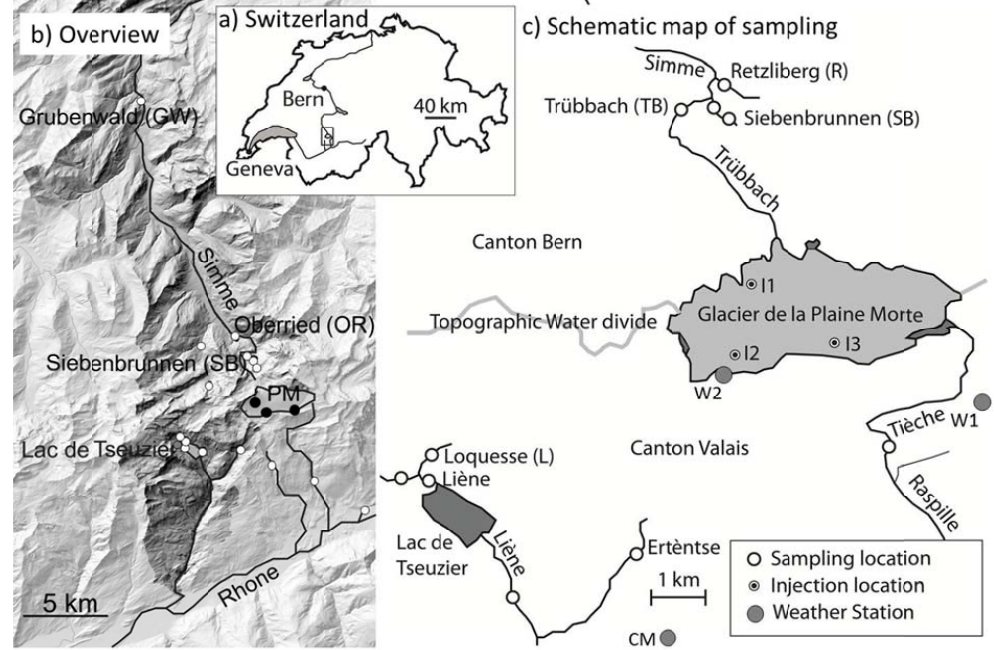
Fig. 1. Overview of the study site including the surroundings of the Glacier de la Plaine Morte (PM). (a) locates the study area with a square in Switzerland, (b) gives a topographic overview of the two valleys to the north and south of the PM (darkened area delimits topographic watershed of the Simme and the Liène); (c) illustrates schematically sampling locations around PM. Dark grey areas on the border of PM illustrate temporary glacier